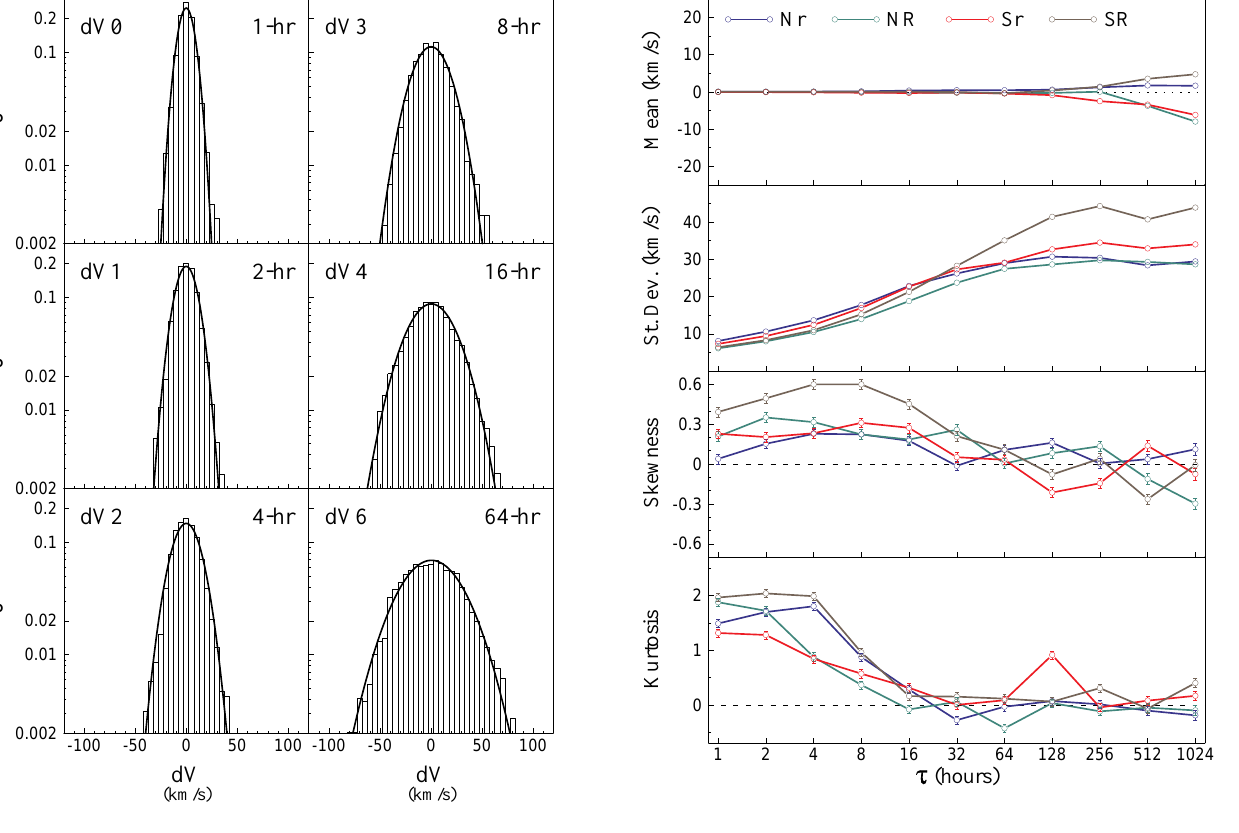
Fig. 6. The dependence of mean, standard deviation, skewness, and kurtosis on the time lag τ is shown separately for the four (Nr, NR, Sr, and SR) Ulysses